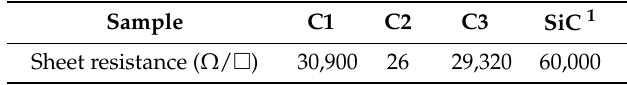
Table 2. Sheet resistance of SiC thin film and graphene inferred by the four points probe method. Sample